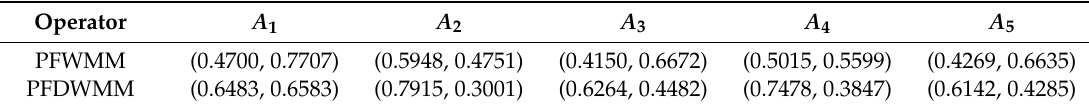
Table 6. The comprehensive evaluation value by PFWMM and PFDWMM operators.